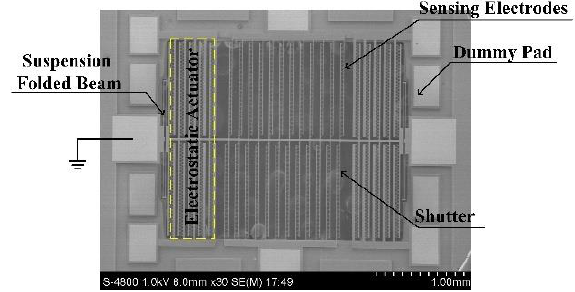
Figure 3. Scanning electron micrograph (SEM) photo of the fabricated EFM.